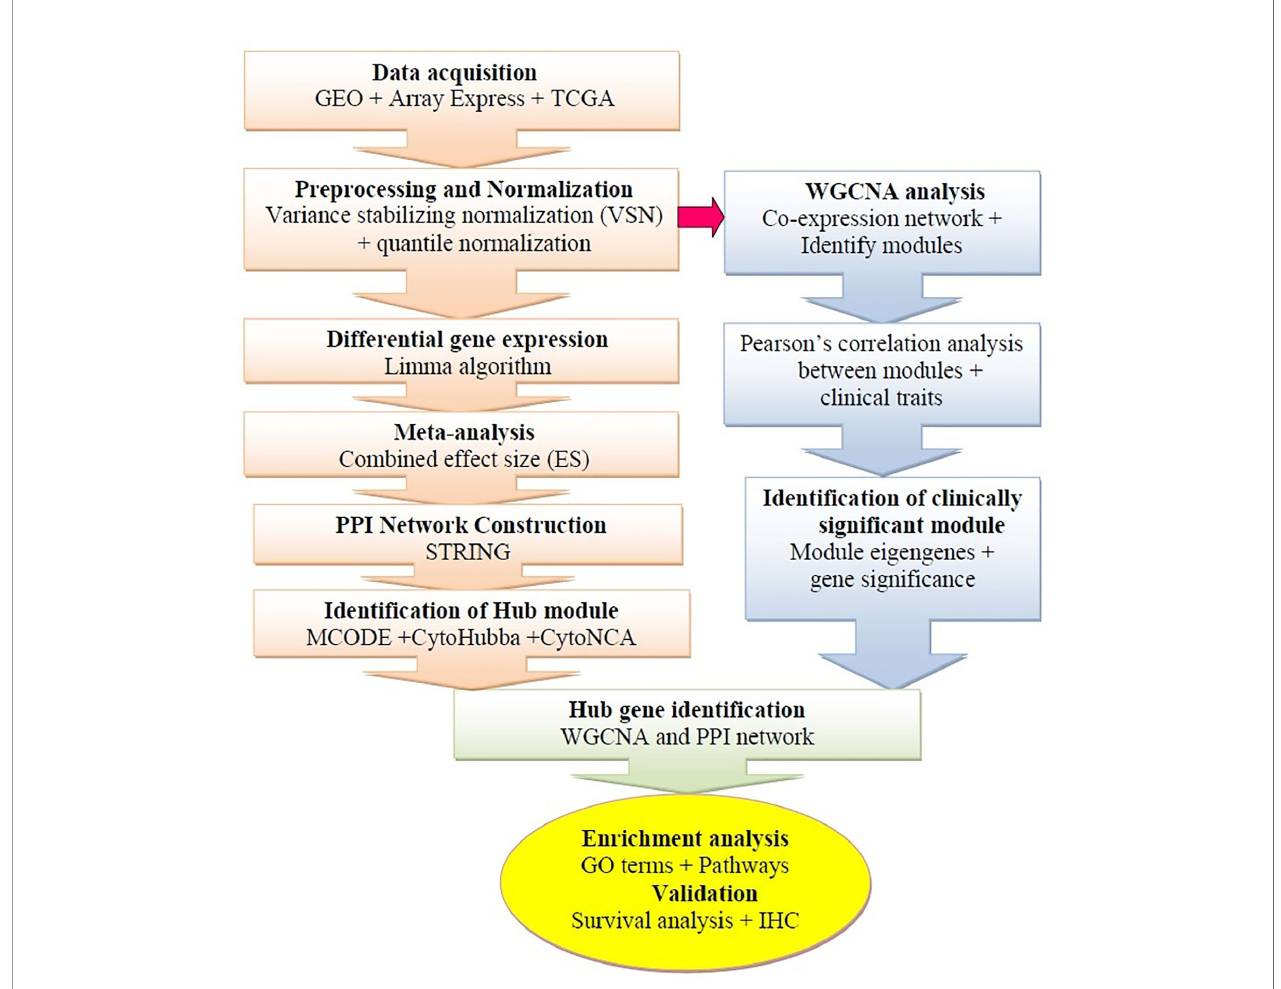
FIGURE 1 | Schematic fl ow diagram of the study. GEO, Gene Expression Omnibus; IHC, Immunohistochemistry; WGCNA, weighted gene co-expression network analysis; TCGA, The Cancer Genome Atlas; PPI, Protein-protein interaction.